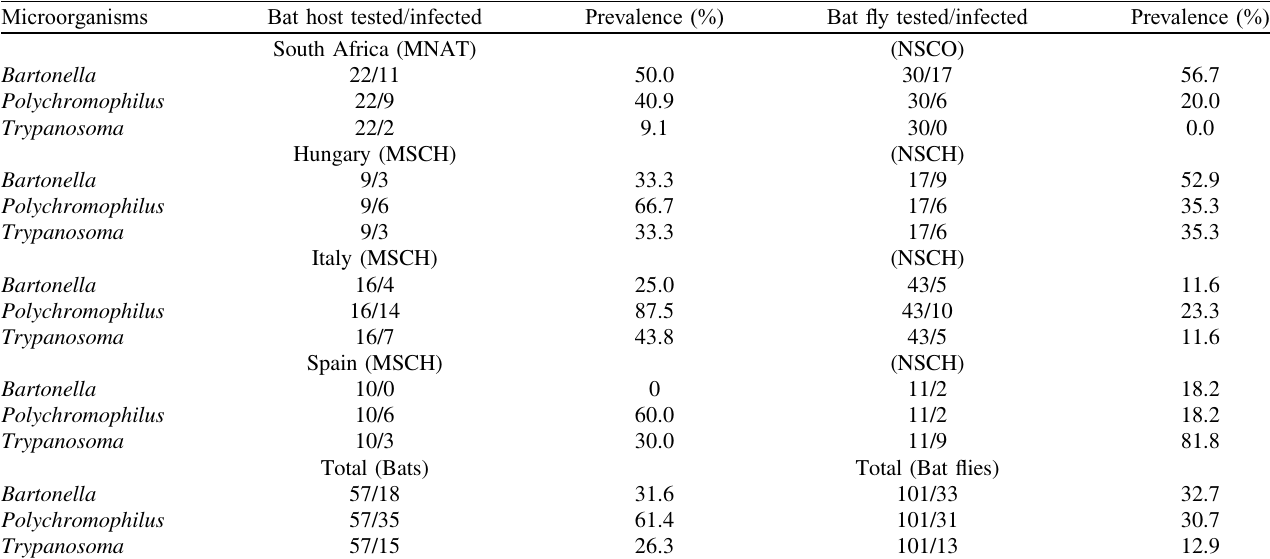
Table 1. Prevalence (%) of Bartonella spp., Polychromophilus spp. and Trypanosoma spp. in bats and their bat fl ies. Microorganisms